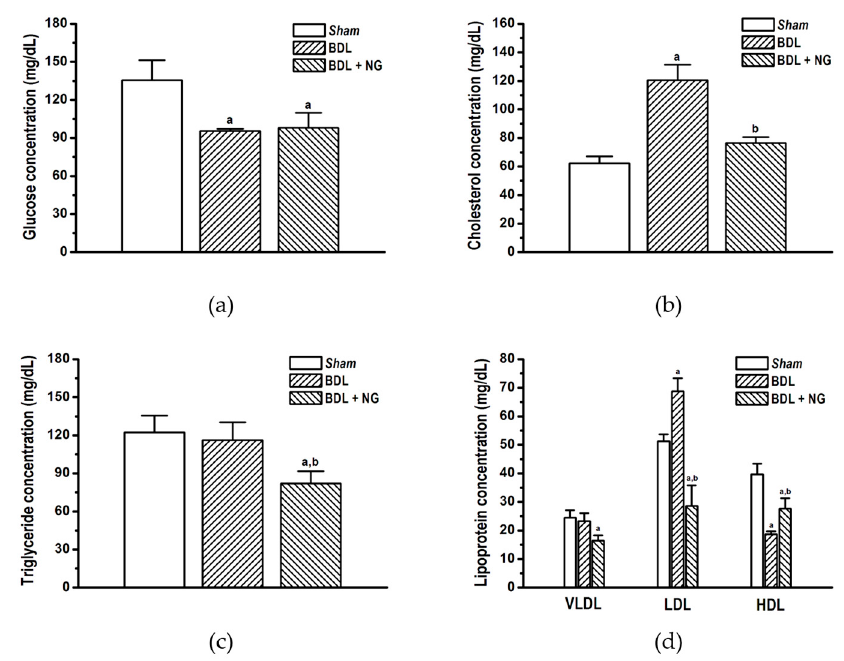
Figure 3. Metabolic biomarkers quantified on bile duct ‐ ligated (BDL) model after administration of naringenin (NG, 50 mg/kg/day) for 10 days. ( a ) Glucose, ( b ) total cholesterol, ( c ) triglycerides, ( d ) lipoprotein (very low ‐ density lipoprotein (VLDL), low ‐ density lipoprotein (LDL), and high ‐ density lipoprotein (HDL)). Data are expressed as means ± SEM ( n = 8 – 10). a: Significantly different from sham control group at p < 0.05, and b: Significantly different from BDL group at p < 0.05 .